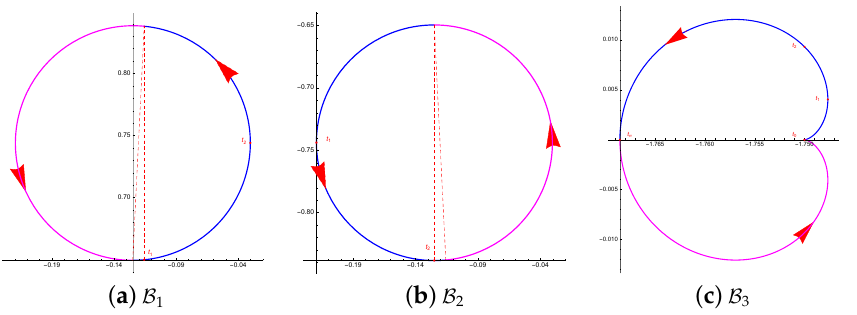
Figure 6. Boundary curves of the three red fixed components R f